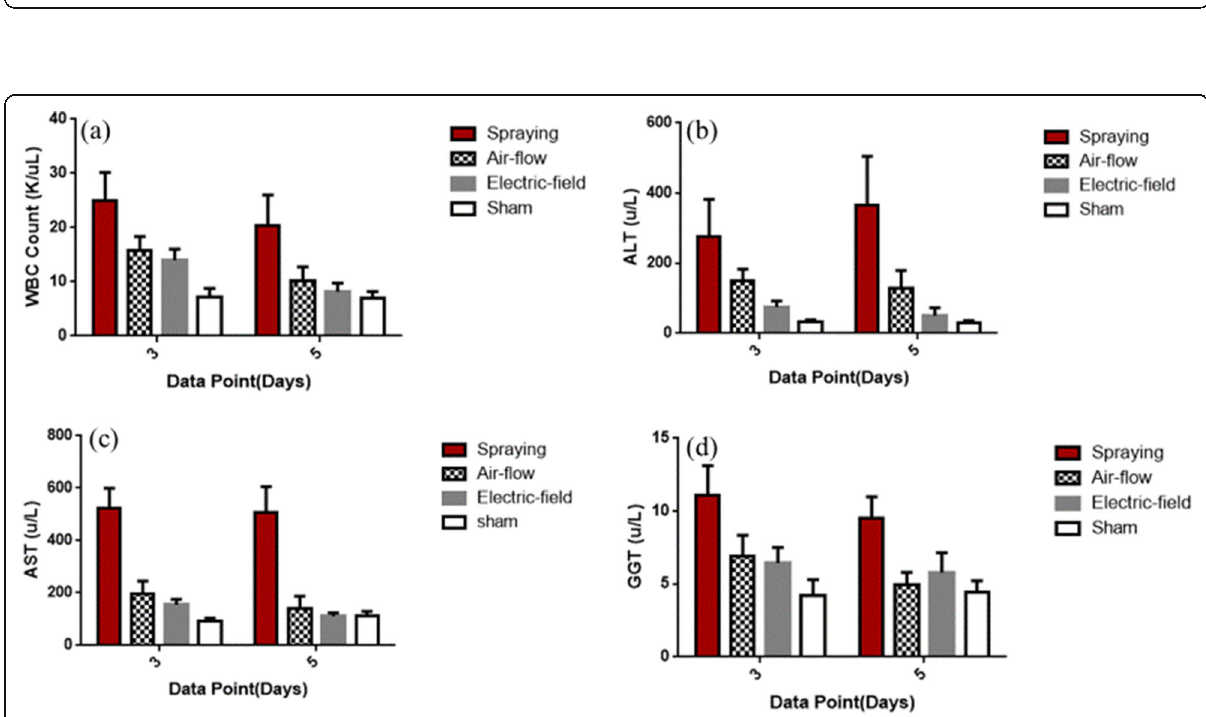
Fig. 4 Hemostasis in a rat liver resection model through in situ electric-field assisted e-spinning. a The liver was dissociated and the liver lobe was exposed. b The lobe was free and fixed with a surgical suture to temporarily block the hepatic blood flow. c A hepatectomy was made and NOCA medical glue fibers were deposited on the wound site with our electric-field assisted e-spinning device. d Cross-sectional SEM image of NOCA medical glue fibers deposited on the liver surface for